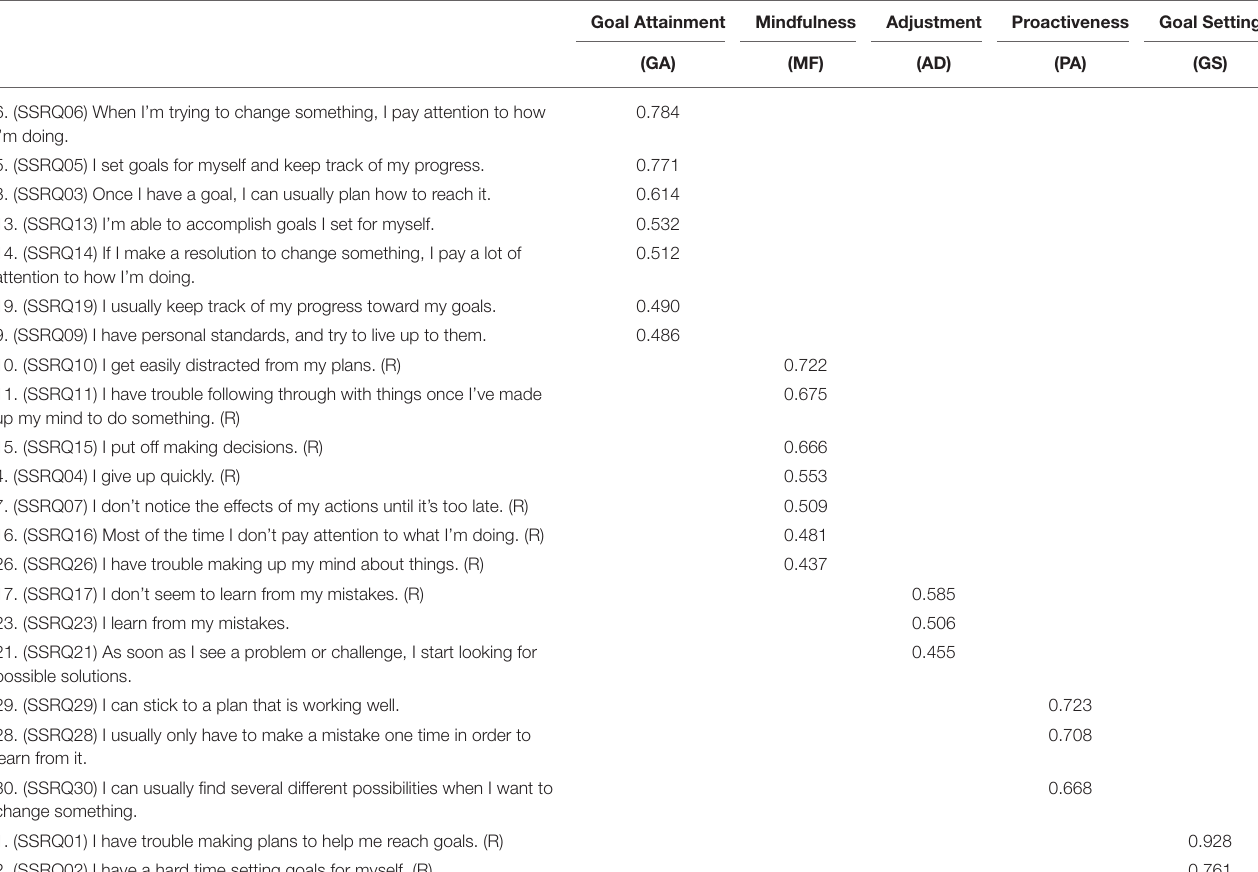
TABLE 4 | Factor structure and item loadings of